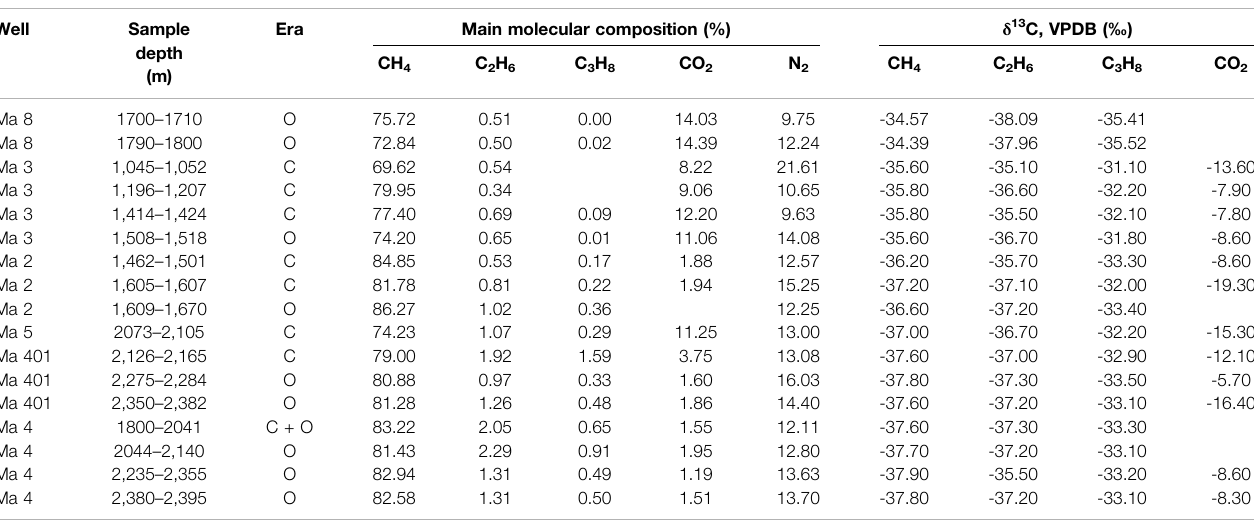
TABLE 2 | Abundance and stable carbon isotopic values in natural gases from Hetianhe gas fi eld. Well Sample